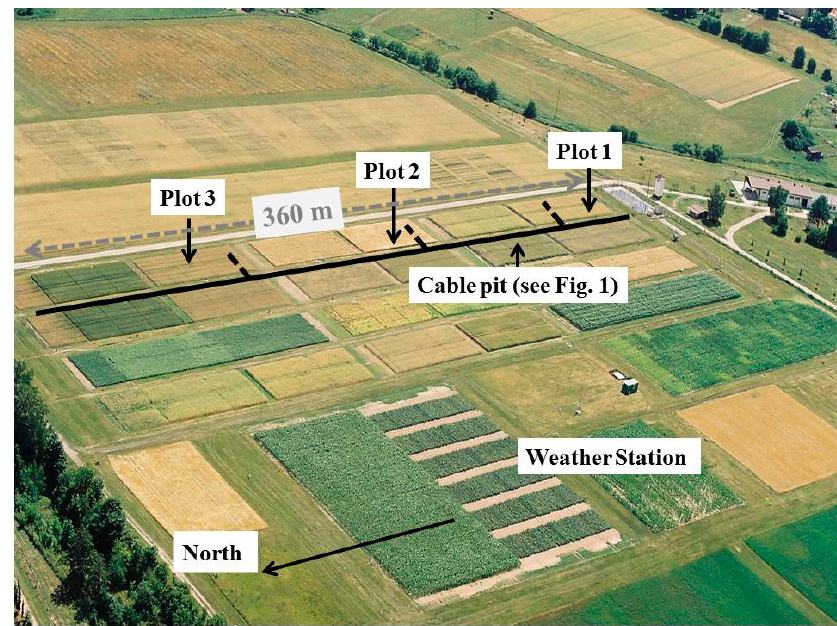
Figure A1. Location of the three field plots (Image by B. Zbell), from ([38], modified). Table A1. Crop rotation, sowing date, harvest date and yield data (t ha − 1 ), Plot 1 ([38], modified). Year Crop 1993 Sugar